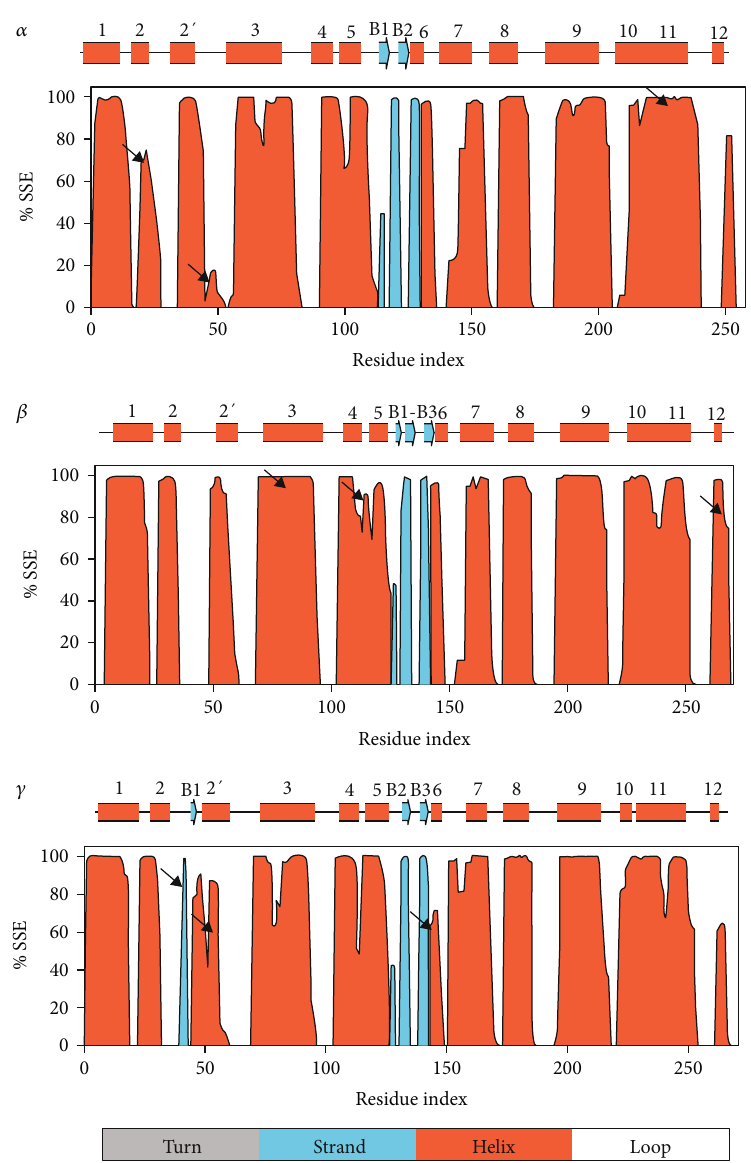
Figure 6: Illustrations of residue index as well as the %SSE in hPPAR receptors: PPAR α (3VI8), PPAR β (3TKM), and PPAR γ (2PRG). Protein receptor secondary structure elements and their composition percentages are